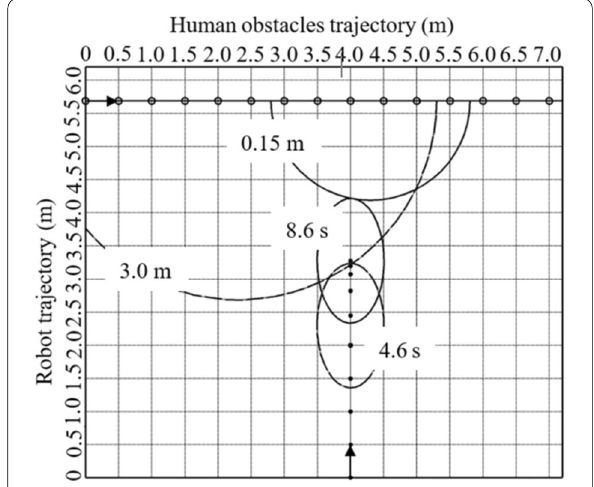
Figure 13 Crossing behavior pattern simulation